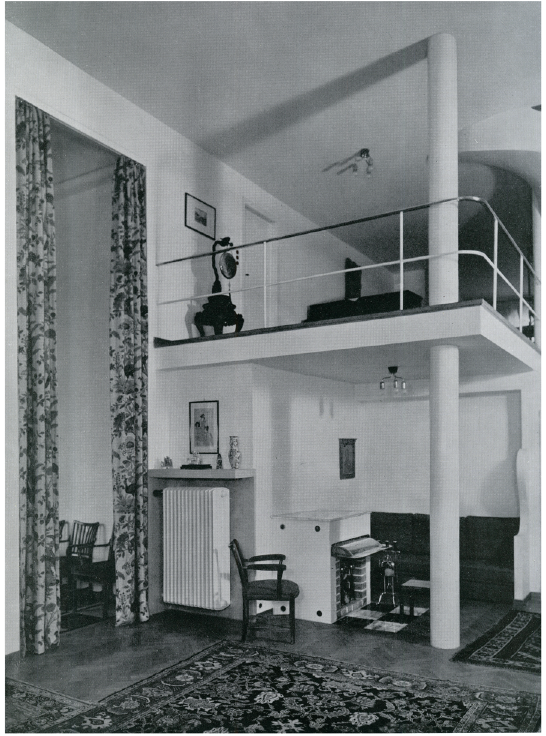
Fig. 4 Villa Beer, Vienna-Hietzing (1930), main hall, view to south- west, including music gallery (Source: Julius Scherb, Vienna